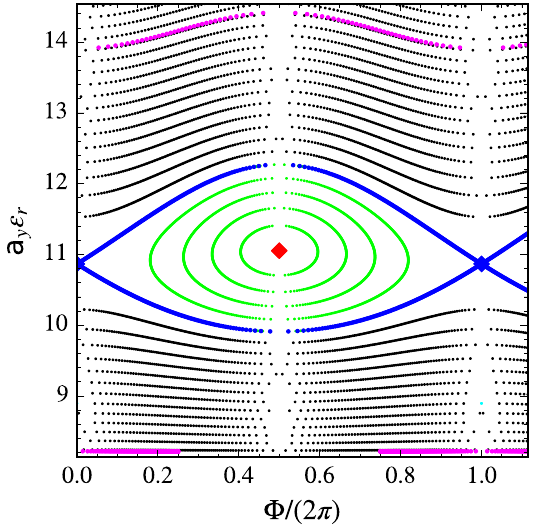
FIG. 5. Fixed line and tori for C ¼ − 5 in a high-intensity coasting